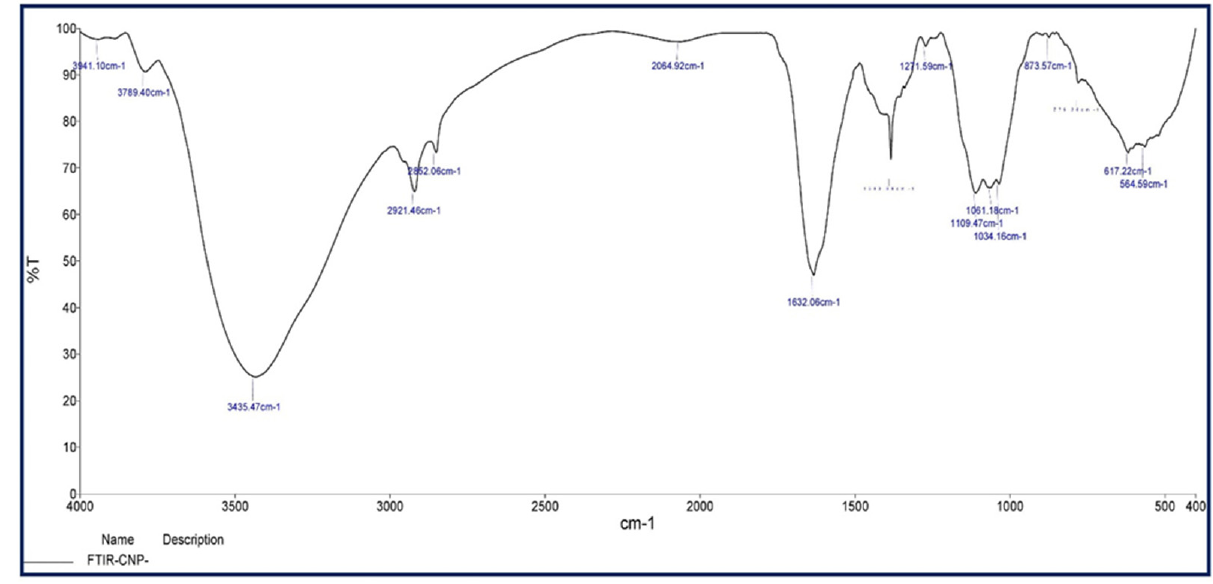
Figure 4. FT-IR analysis of